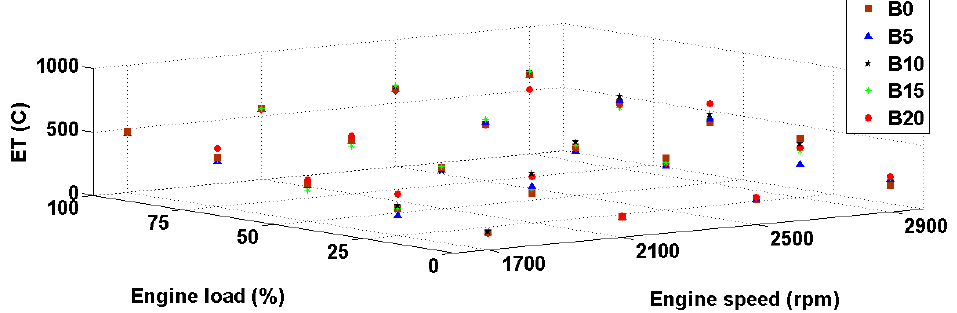
Figure 10. Exhaust gas temperatures of the engine under different engine loads, speeds and biodiesel percentages.